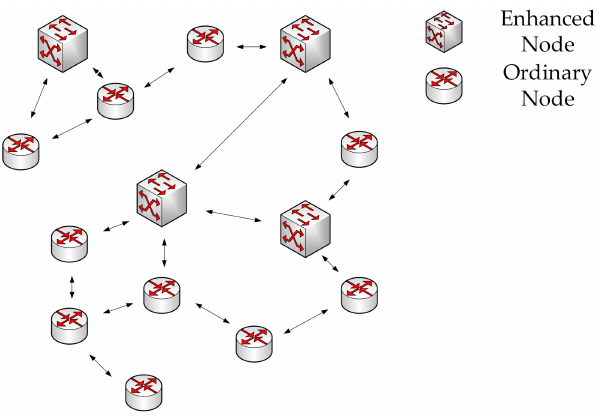
Figure 1. The node connectivity architecture of